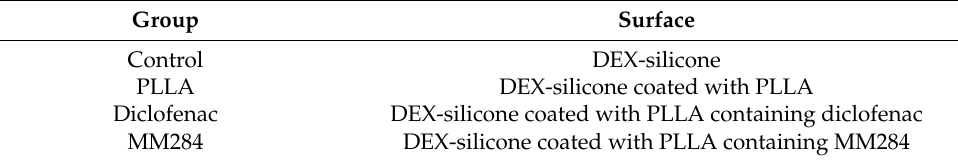
Table 1. Overview of group division. Group Surface Control DEX-silicone PLLA DEX-silicone coated with PLLA Diclofenac DEX-silicone coated with PLLA containing diclofenac MM284 DEX-silicone coated with PLLA containing